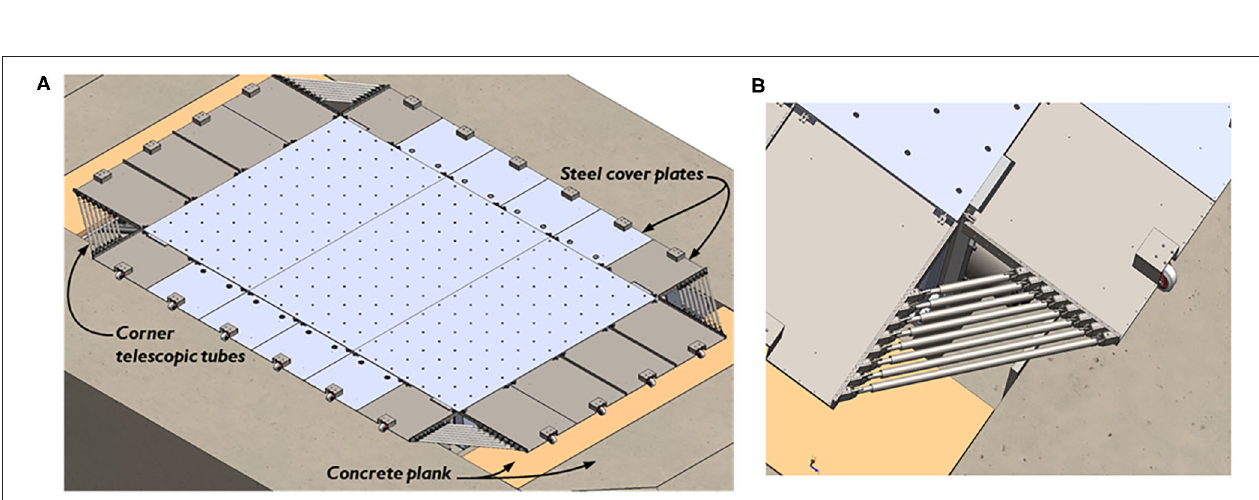
Frontiers in Built Environment |